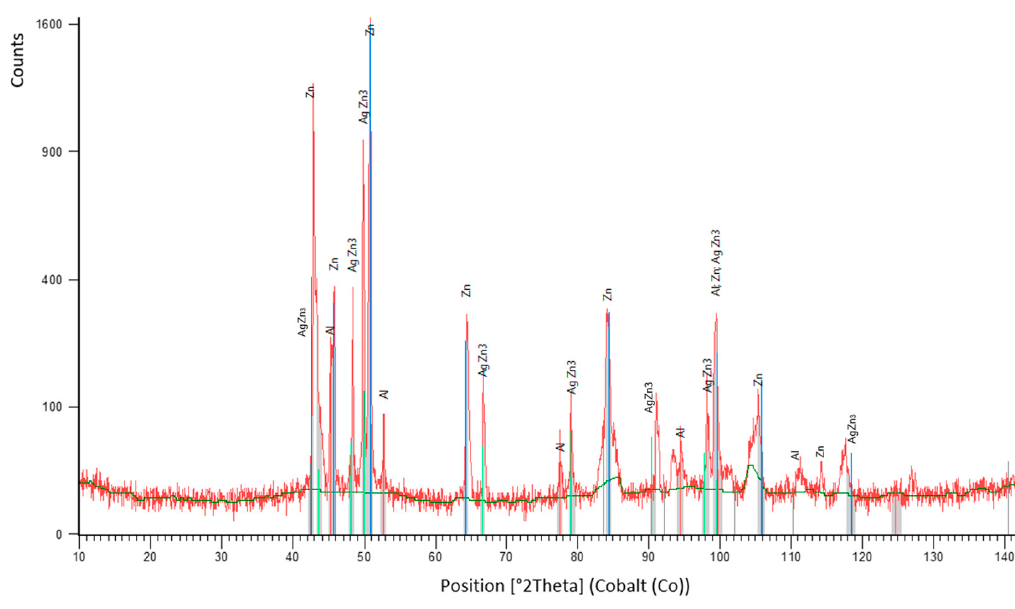
Figure 8. The X-ray diffraction (XRD) record of Zn6Al6Ag solder.